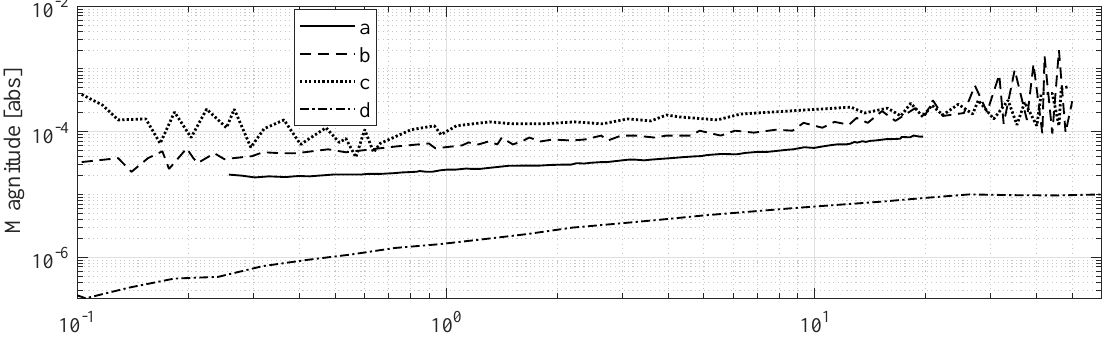
Figure 7. Reported frequency responses for IPMC voltage sensing according to [125] ( a ), [128] ( b , c ), and [133] ( d